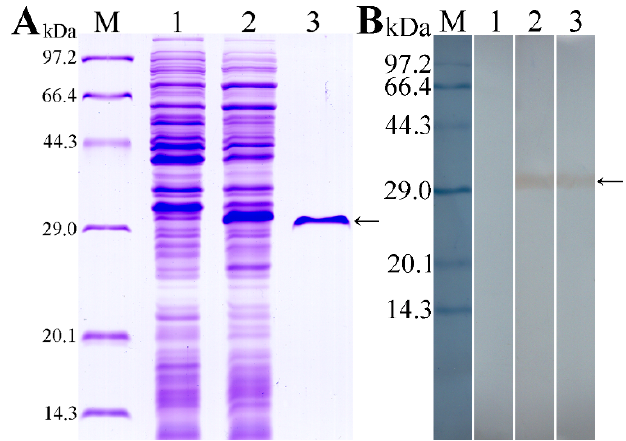
Figure 3. Neighbor-joining phylogenetic tree of trypsin.